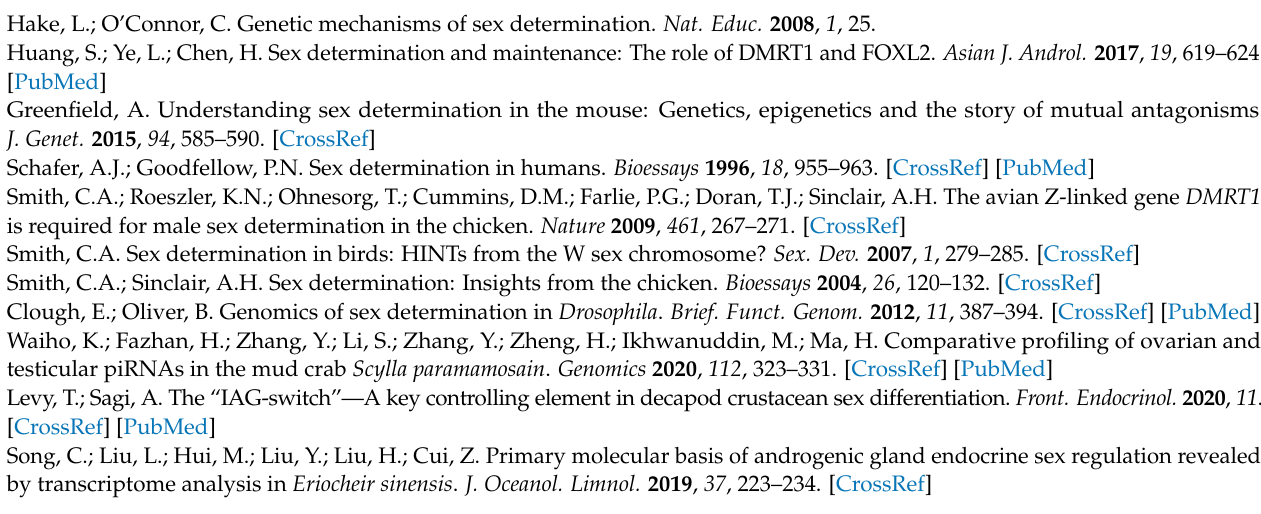
Table S1: Statistics of Iso-Seq and RNA-Seq sequencing results for Artemia franciscana ; Table S2: Summary of annotations of Artemia franciscana transcriptome; Table S3: Female-specific enriched Gene Ontology (GO) terms; Table S4: Male-specific enriched Gene Ontology (GO) terms; Table S5: Information of isoforms of DMRT1 , Dsx , and Sad genes in Artemia franciscana